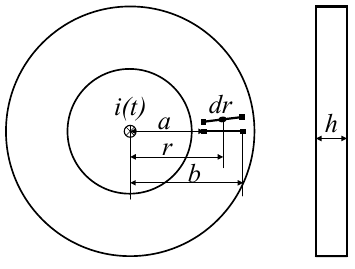
Figure 5. Structure of the planar PCB Roche coil.